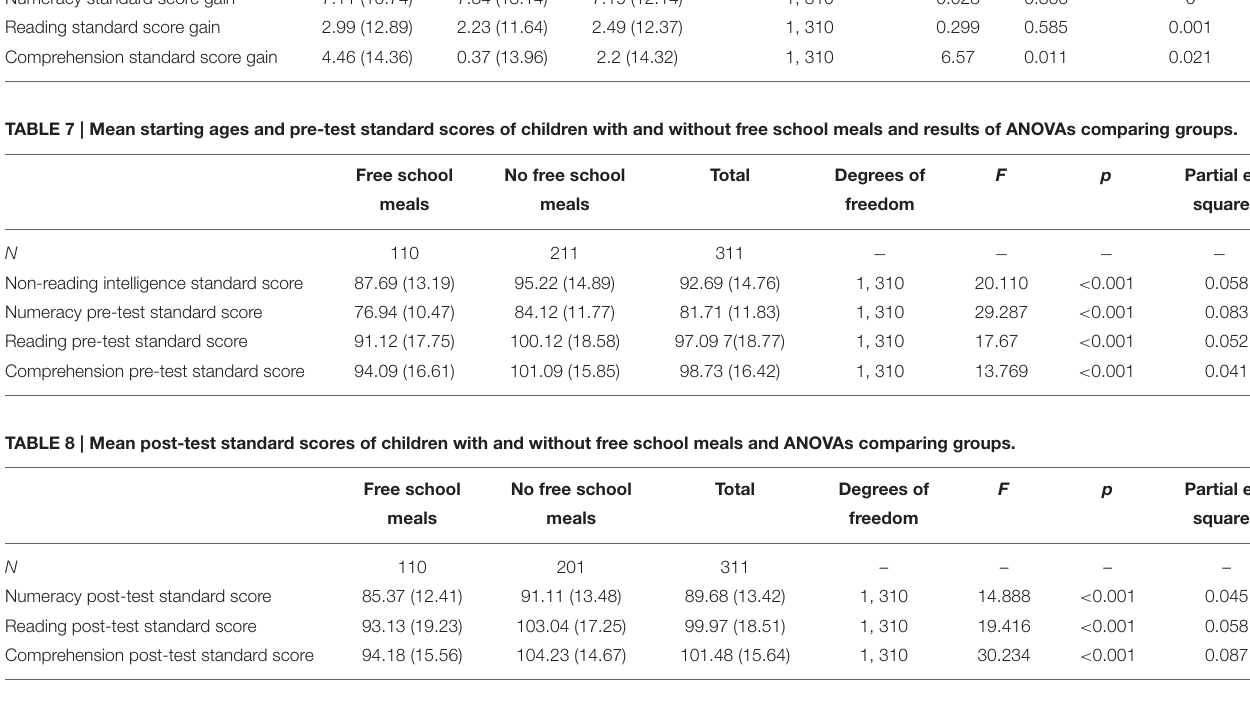
TABLE 9 | Mean standard score gains by children with and without free school